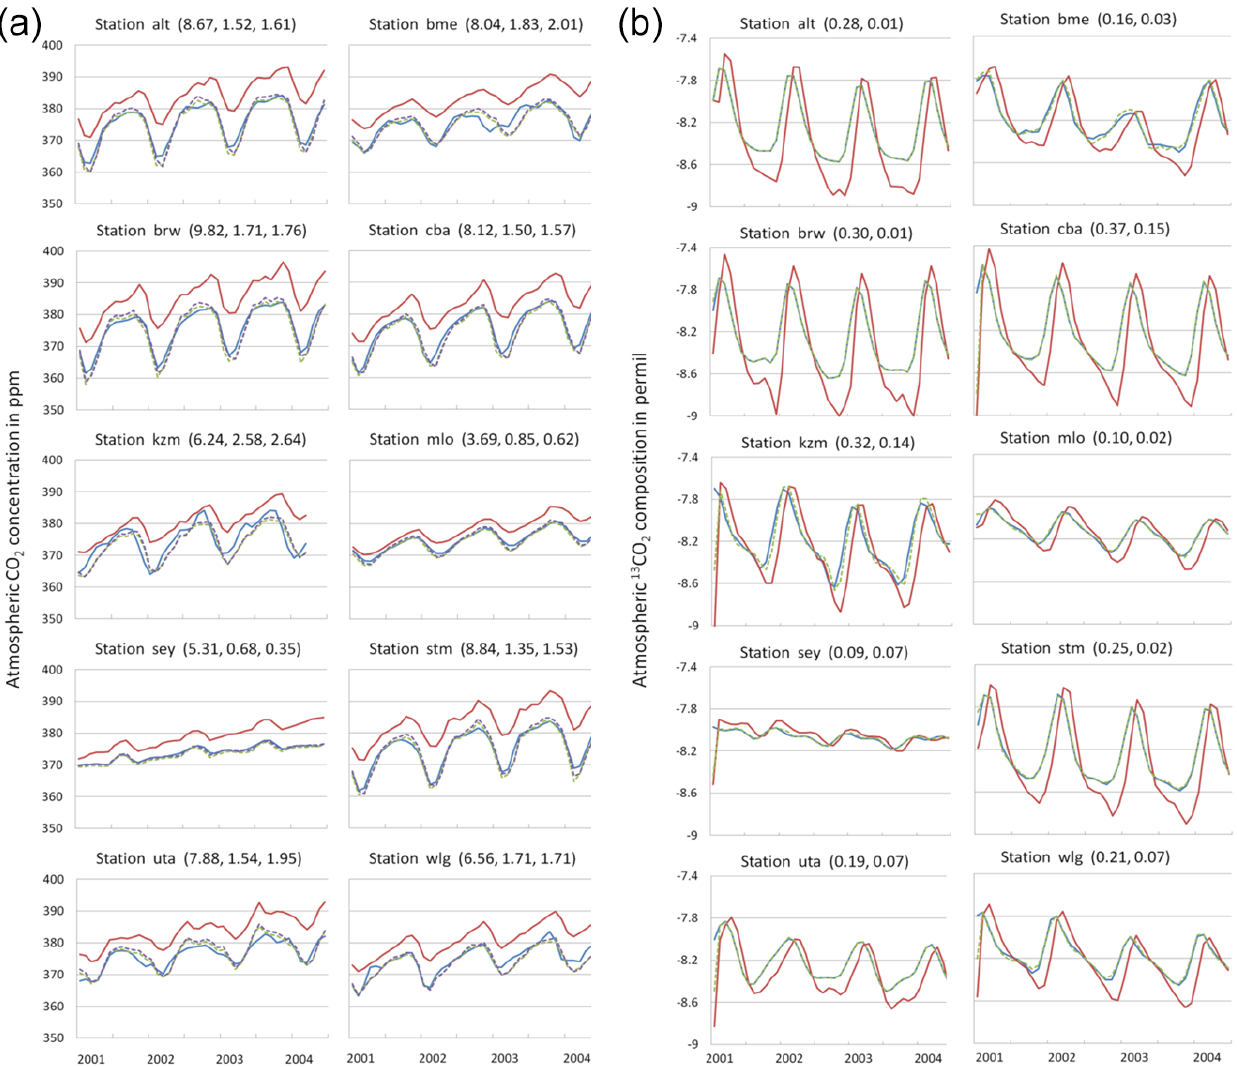
Figure 13. Left panel: comparison of CO 2 concentrations calculated using the prior flux (solid red) and from CO 2 -only inversion (dashed purple) and joint inversion (dashed green) against observations (blue) at 10 randomly selected stations from different regions. The header of each plot indicates the station ID and the root mean square difference (RMSD) for the prior, joint and CO 2 -only inversions against obser- vations. Right panel: comparison of 13 CO 2 composition from the prior (solid red) and joint inversion (dashed green) against observations (blue). The header of each plot indicates the station ID and RMSD of the prior and the joint inversion against